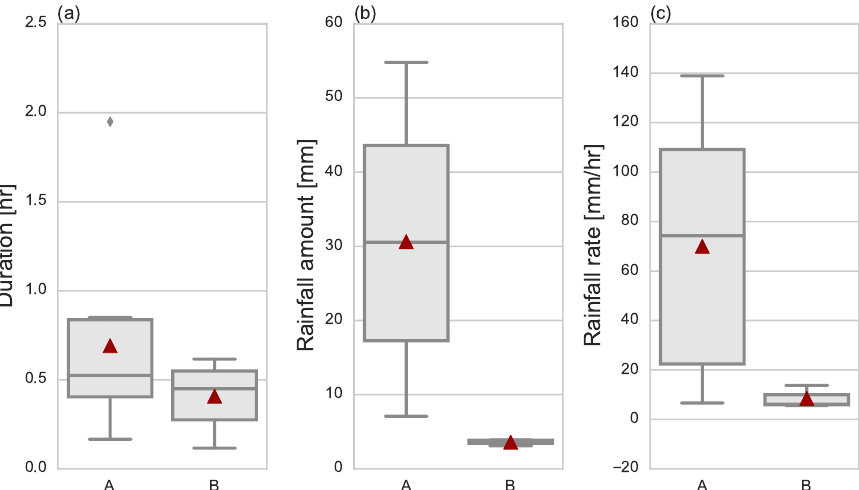
Figure 7. Comparison of type A and type B rainfall events with respect to ( a ) the duration of the event (unit: hr), ( b ) the cumulative rainfall amount (unit: mm), and ( c ) the associated rainfall rate (unit: mmhr − 1 . The red triangle marks the mean, the center horizontal line marks the median, the upper and lower boundaries of the box contain the interquartile range, and the top and bottom of the vertical line represent the maximum and minimum values, excluding any outliers (grey diamonds).